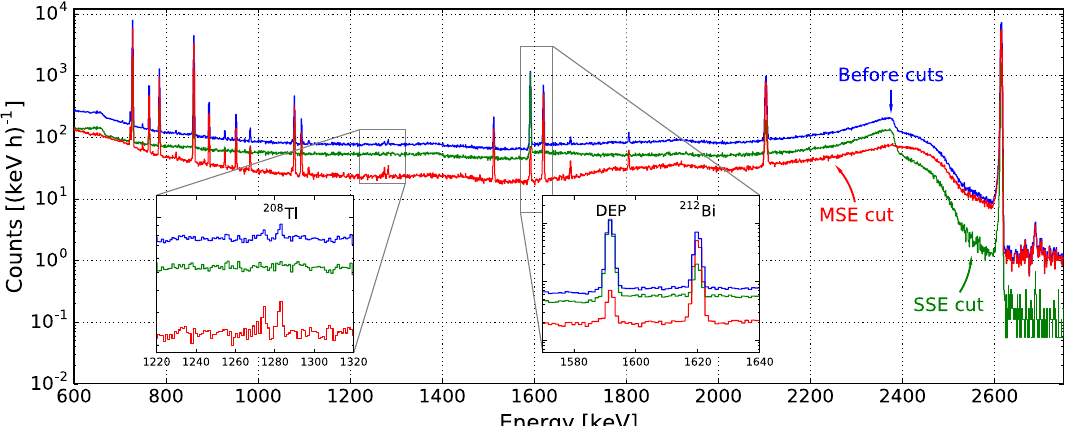
Fig. 7 Effect of the PSA cut on the 228 Th spectrum (DEP/FEP training variant). The exact values for the SSE cut (rejecting MSE) and MSE cut (rejecting SSE) are described in the text. For the SSE cut, the DEP is